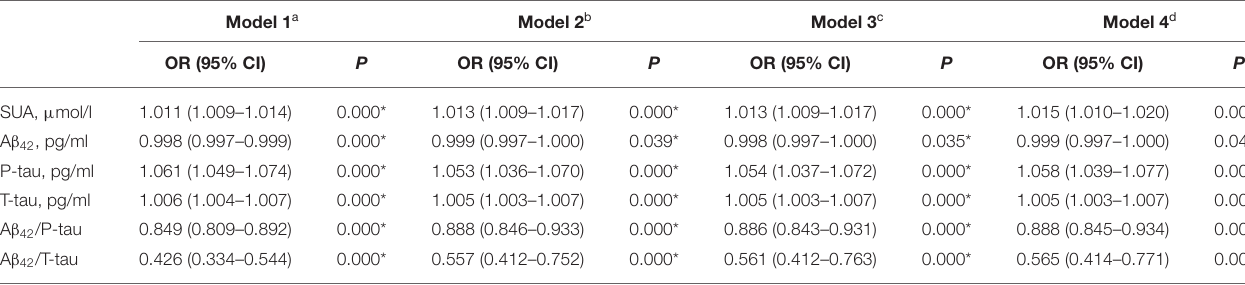
TABLE 3 | Logistic regression on analysis and sensitivity analysis in PNDABLE study.